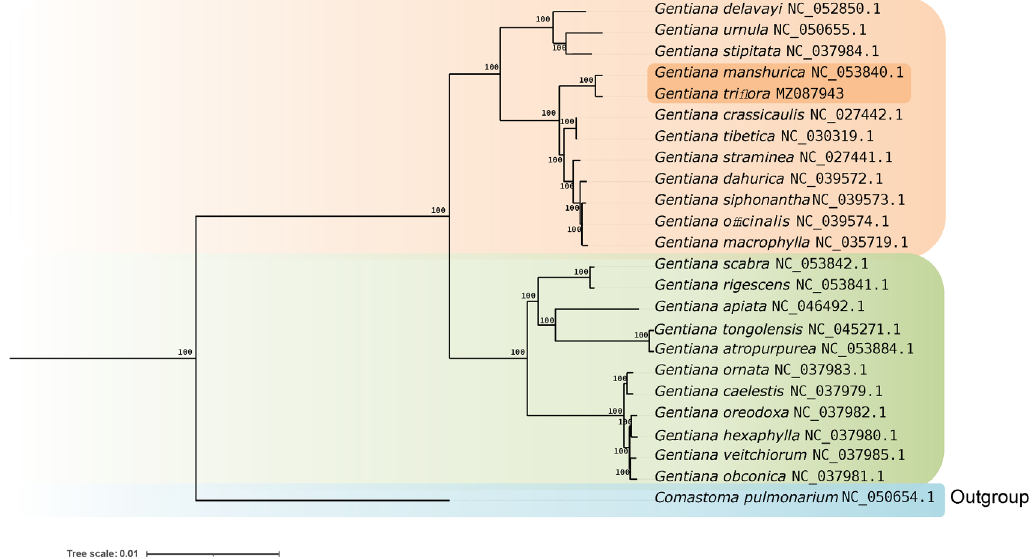
Fig. 7: Phylogenetic analysis of 23 species of Gentiana and Taxon Comastoma pulmonarium as outgroup based on chloroplast genome sequences by RAxML and bootstrap support values near the branch. The Gentiana genus was grouped into two clades (presented with different background colors). The G. triflora was closely related to the G. manshurica.